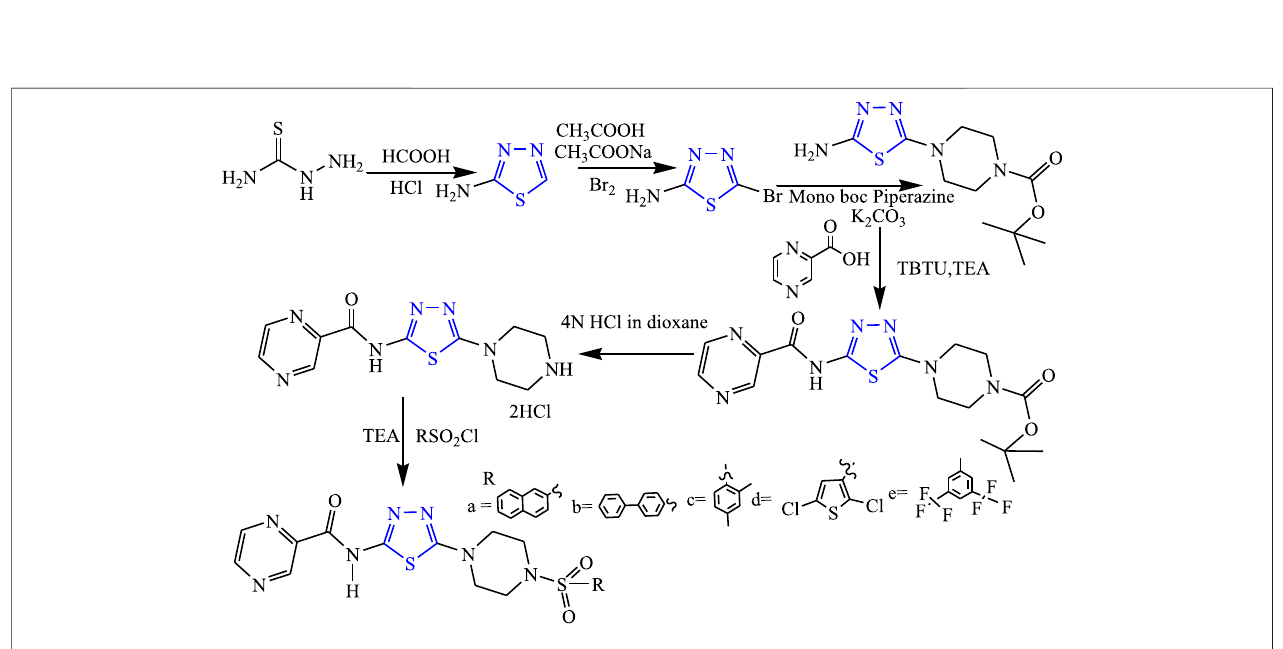
FIGURE 15 | Systematic scheme for synthesizing substituted 1,3,4-thiadiazole pyrazines derivatives.